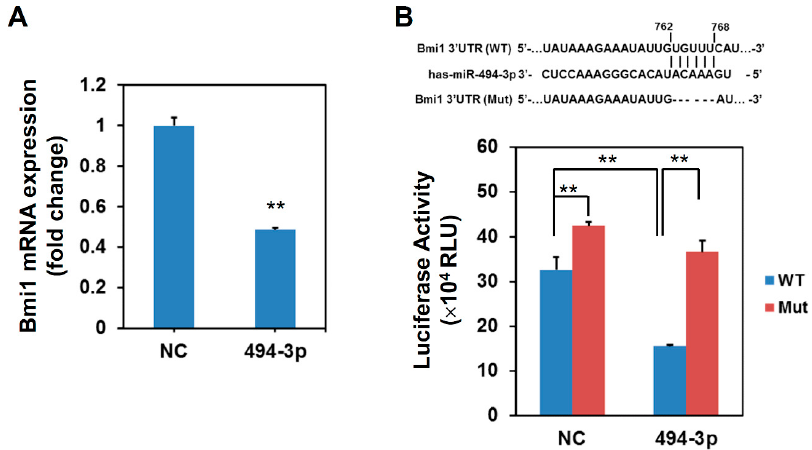
Figure 3. Bmi1 was a target of miR-494-3p in SAS cells. ( A ) Negative control mimic (NC) or miR-494-3p mimic (494-3p) was transfected into SAS cells and total RNA were extracted at 48 h post-transfection. The mRNA expression of Bmi1 was determined by qRT-PCR. **, p < 0.01; ( B ) Schematic presentation of the constructed Bmi1 3 ′ -untranslated region (UTR) reporter plasmids were used in this study. WT, wild type; Mut, mutant. SAS cells were transfected with negative control mimic (NC) or miR-494-3p mimic (494-3p) simultaneously with Bmi1 3 ′ -UTR reporter plasmid for 48 h. The cells were then lysed with passive lysis buffer and the luciferase activity was determined. **, p < 0.01.